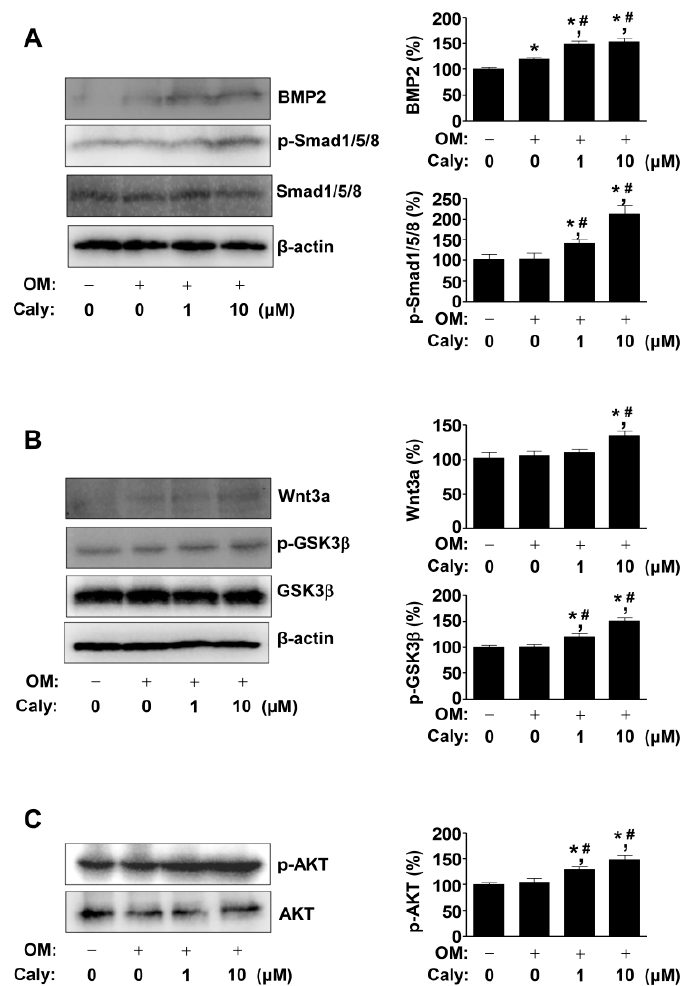
Figure 3. Effects of Caly on the BMP2, Wnt3a, and AKT signaling pathways during the osteogenesis of human MSCs. ( A – C ) BMP2 expression, Smad1/5/8 phosphorylation (p-Smad1/5/8), β -actin expression ( A ), Wnt3a expression, GSK3 β phosphorylation (p-GSK3 β ), β -actin expression ( B ), AKT phosphorylation (p-AKT), and AKT expression ( C ) were analyzed using Western blot analysis. The bar graph shows relative expression level (%) normalized to the control (right). Data are expressed as the mean ± S.E.M. from three separate experiments (* p < 0.05 compared to the control, and # p < 0.05 compared to